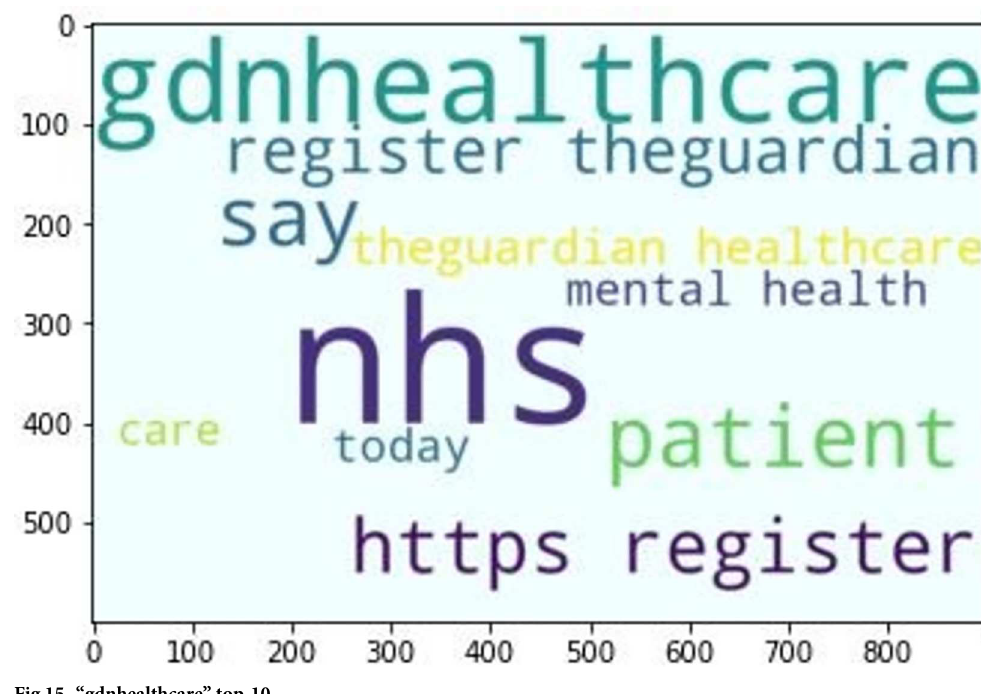
Fig 15. “gdnhealthcare” top-10. https://doi.org/10.1371/journal.pone.0260761.g015 (Figs 19 and 20) where there was a parallel symmetric decrease of sentiments towards negative and objective feedbacks, which imbalances the overall positivity of tweets as well as their subjectivity.